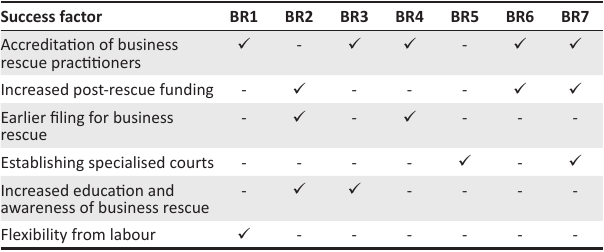
FIGURE 3: Competencies required to be an effective business rescue